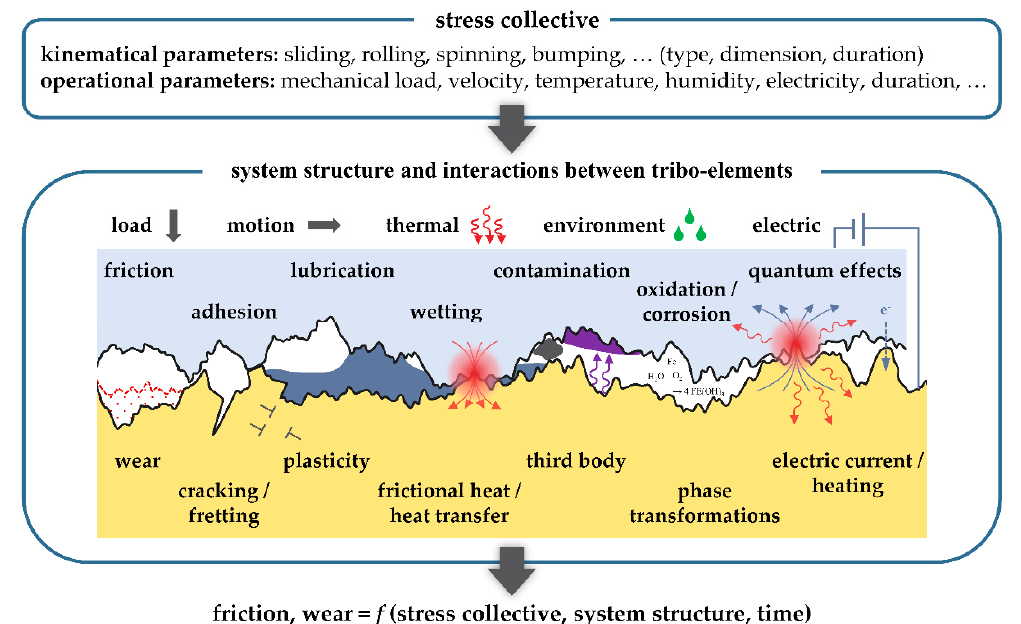
Figure 1. Parameter groups of tribological experiments and interaction in tribo-contacts accordingly. Redrawn from [11,13].